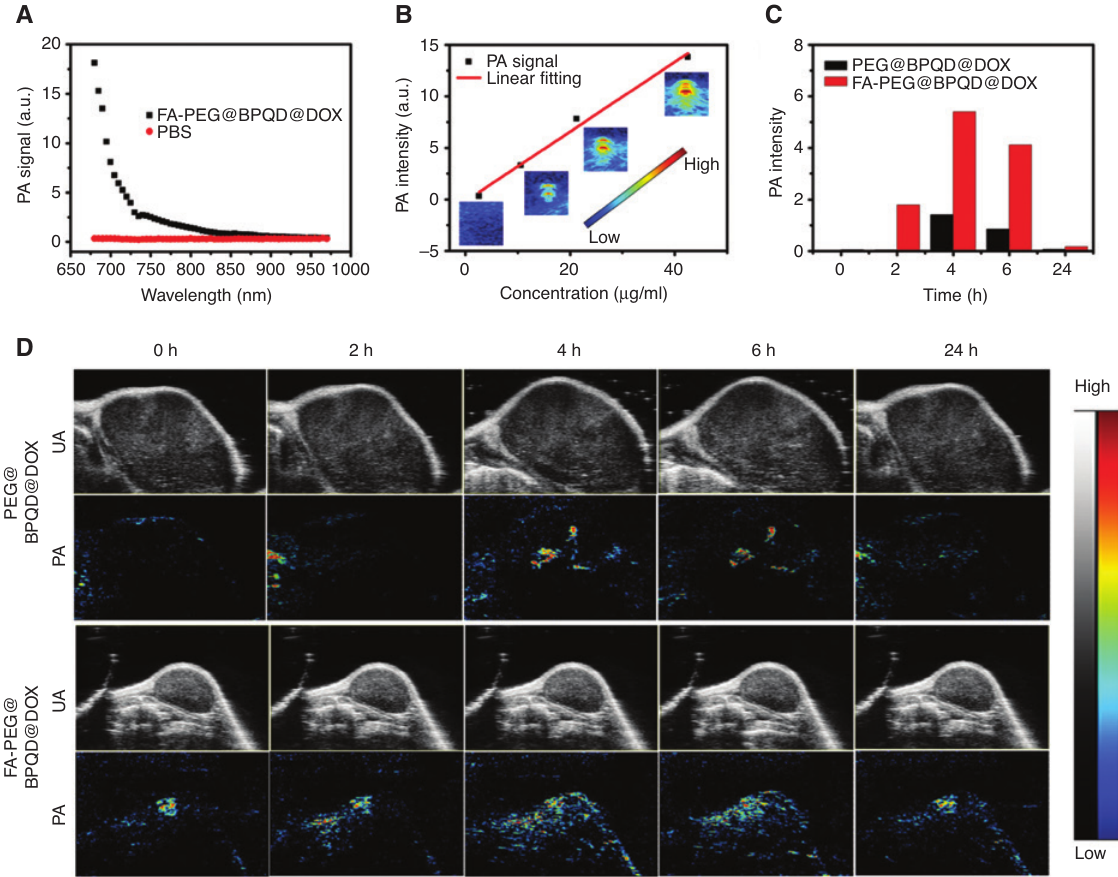
Figure 6: PA performance of FA-PEG@BPQD@DOX. (A) The PA spectrum of FA-PEG@BPQD@DOX and PBS. (B) The FA-PEG@BPQD@DOX NP dispersions of different concentrations